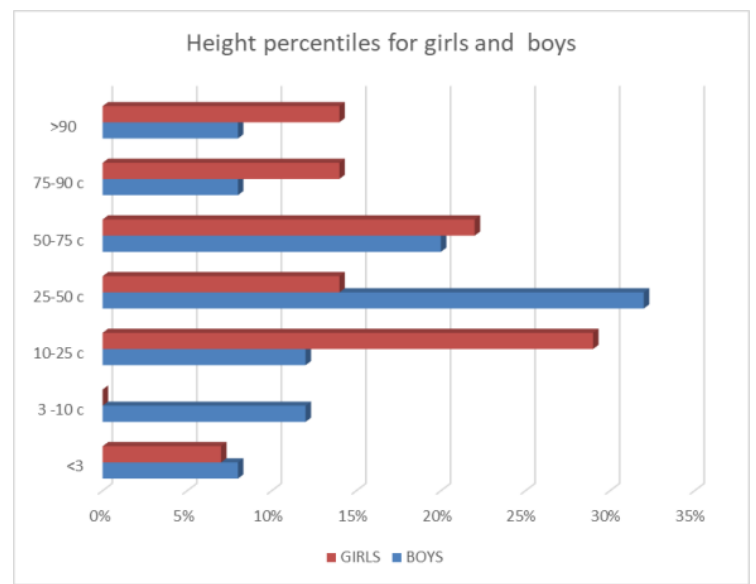
Figure 1. Distribution of percentiles for height.